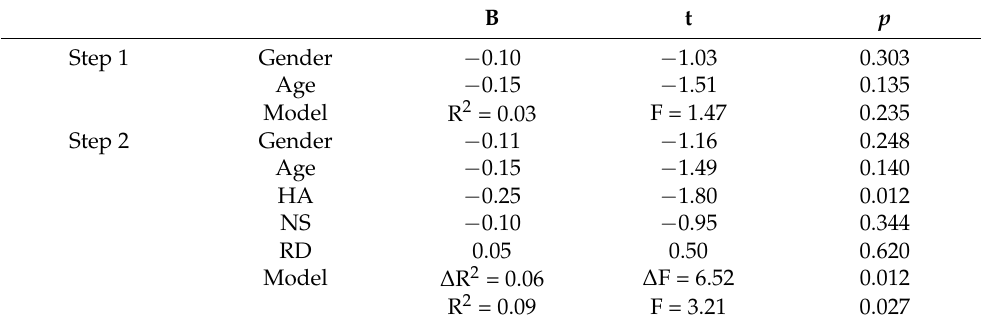
Table 2. Results of a hierarchical regression analysis with Body Mass Index (BMI) as the dependent variable and the Junior Temperament and Character Inventory (JTCI) scales as predictors (N = 100).